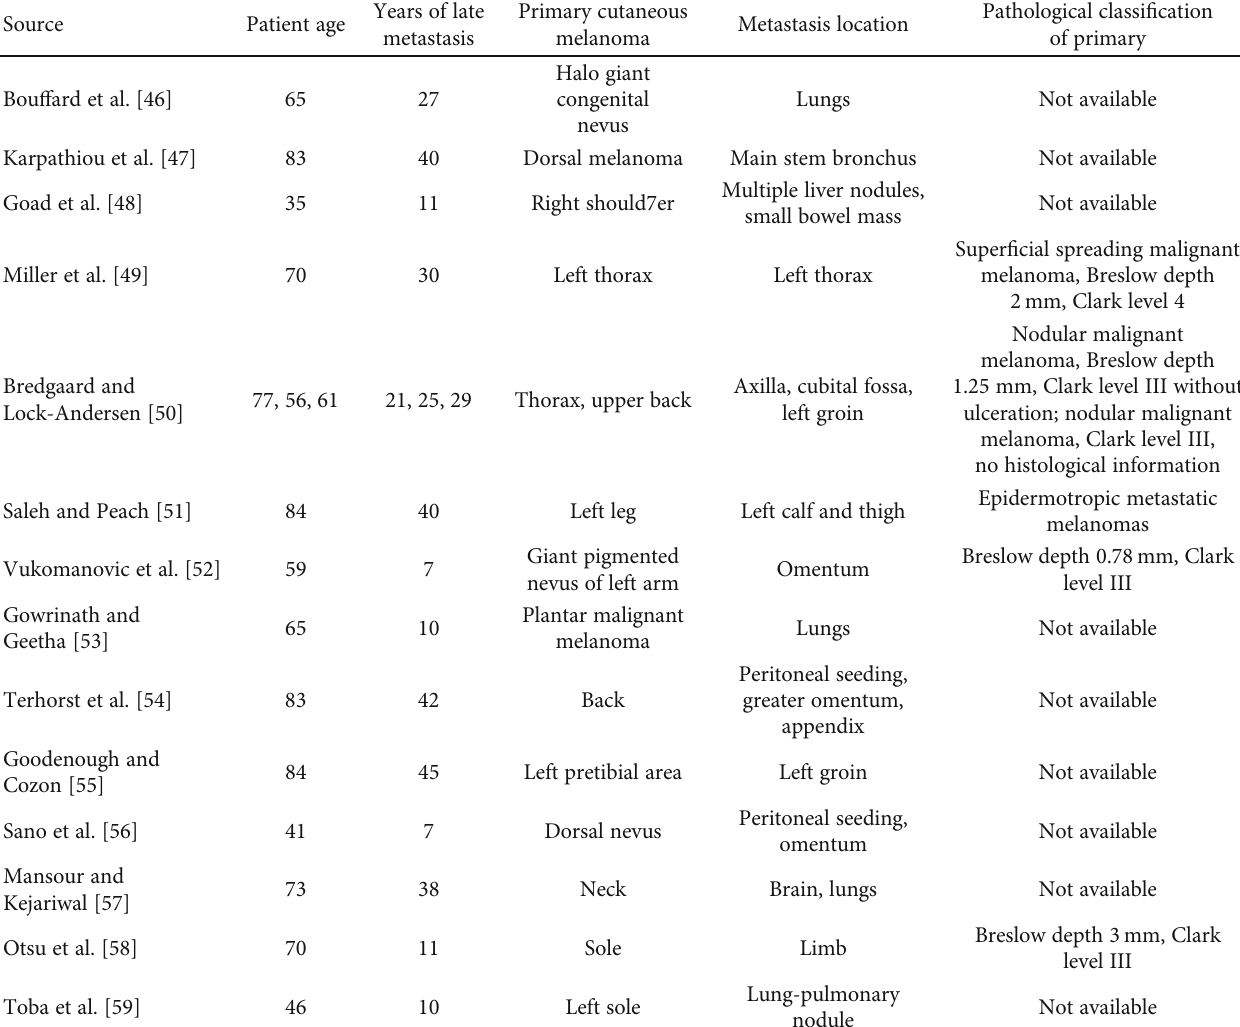
Table 2: List of case reports found in literature with information regarding the year and site of metastasis and the pathological characteristics of the primary tumor (usually > 10 years) from